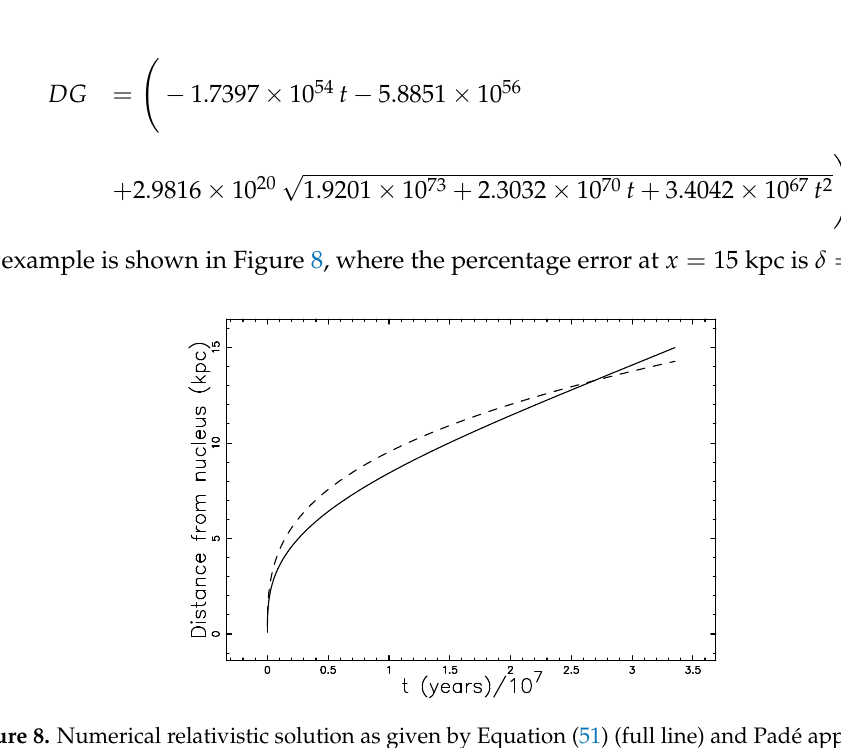
Figure 8. Numerical relativistic solution as given by Equation (51) (full line) and Padé approximant as given by Equation (8) (dashed line), with parameters as in Table